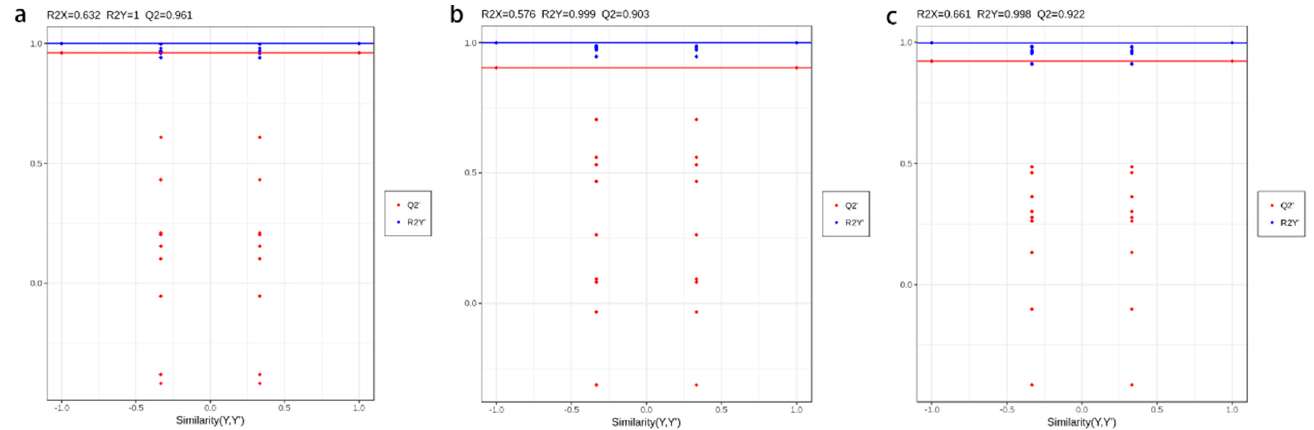
Figure 3. The model verification of OPLS-DA: ( a ) RS vs. GP; ( b ) RS vs. ZJ; ( c ) GP vs. ZJ. Horizontal lines correspond to the original model of R2Y and Q2, and the red and blue dots represent Q2’ and R2Y’ of the model after replacing Y, respectively. R2Y is the interpretation rate of the model to the Y matrix (Class label), and Q2 is the predictive ability of the model.